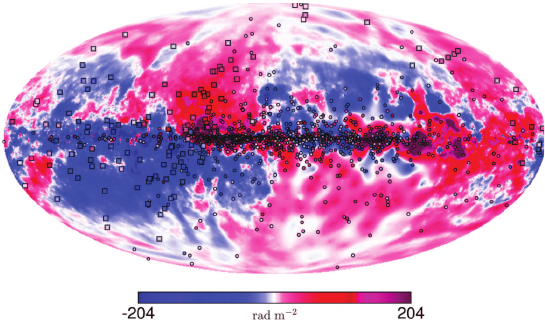
Figure 7. All-sky map in Galactic coordinates (with the Galactic center in the middle) of the RMs of 1133 Galactic pulsars from the current pulsar catalogue (1.59) [27]. The squares correspond to the 137 new RMs obtained with the LOFAR High-Band An- tenna (HBA) at (cid:3) (110 − 190)MHz. The background represents the all-sky Galactic Faraday depth (defined by Eq. (9)) recon- structed from the RMs of extragalactic sources [28]. Positive (negative) RMs are plotted in red (blue).